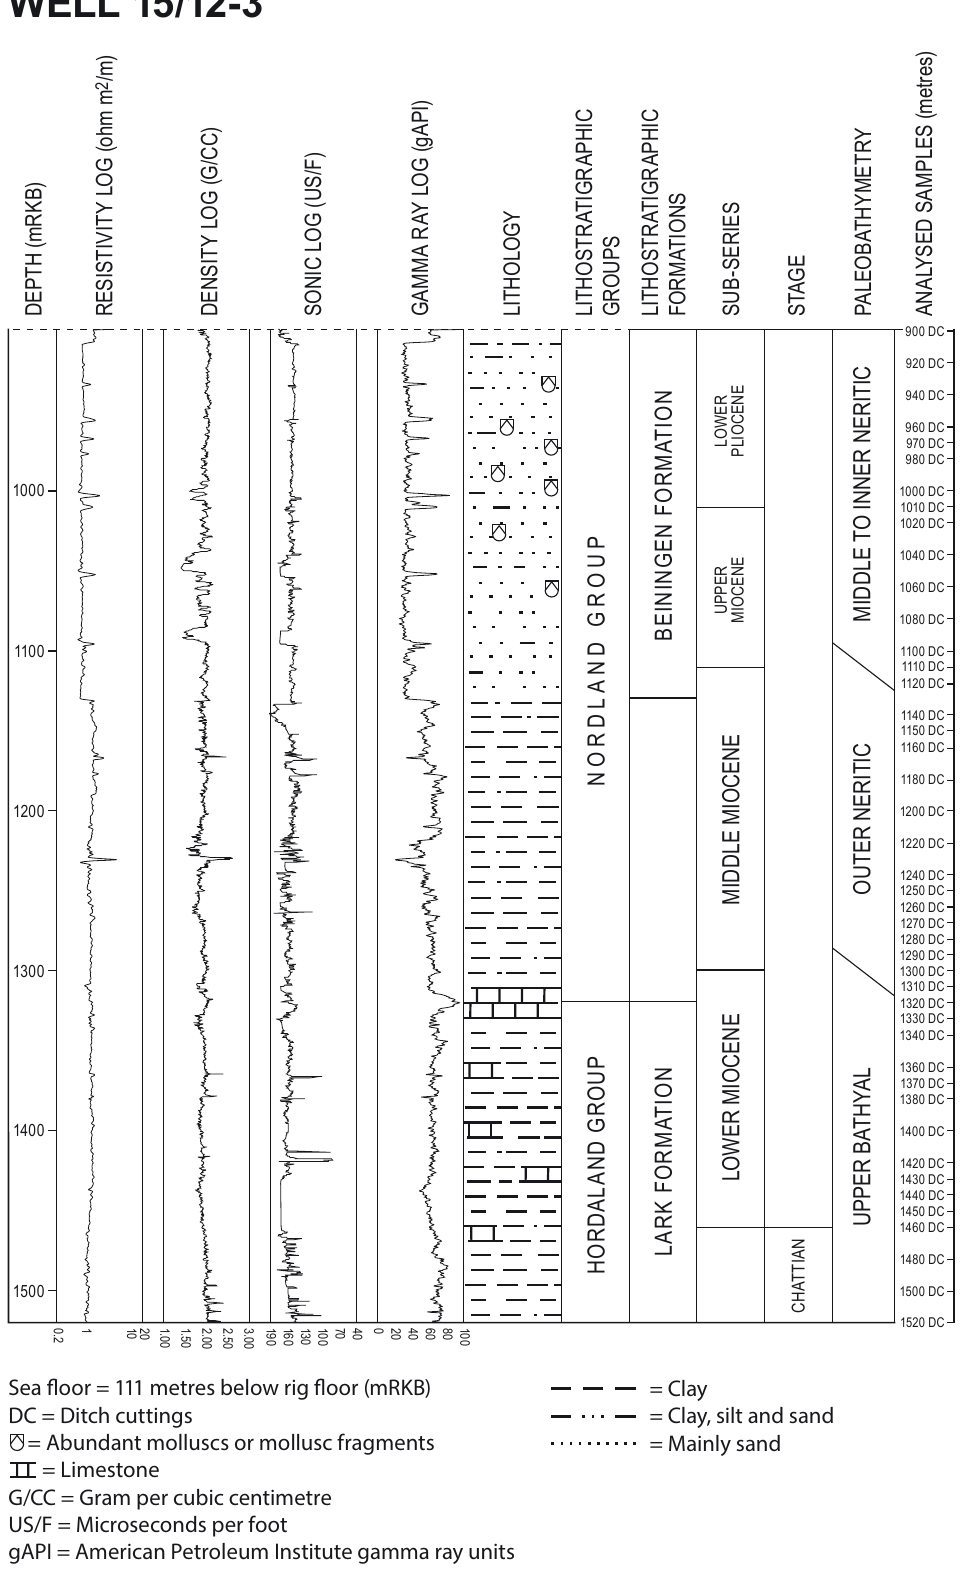
Figure 65. Well summary figure including resistivity log, density log, sonic log, gamma-ray log, lithology, litho- stratigraphic units, sub-series, stage, paleobathymetry and analysed samples for the lower part of the investigated sequence in well 15/12–3 (Chattian to lower Pliocene; modified after Eidvin et al., 1999,